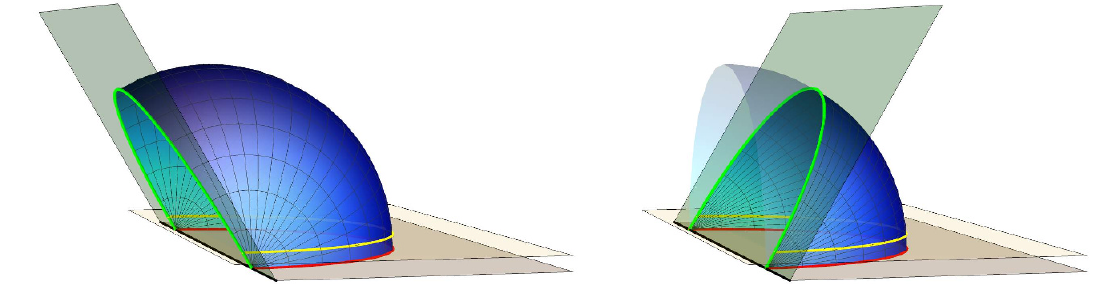
Figure 8 . Minimal surfaces ^ (cid:13) A corresponding to the half disk centered on the boundary. The green half plane is Q in (4.3), while the grey half plane is z = 0. In the left panel (cid:11) < (cid:25)= 2, while in the right panel (cid:11) > (cid:25)= 2. The green curve is ^ (cid:13) A \ Q and the red curve is the entangling curve @A \ @B , whose length enters in the area law term of (5.1). The yellow half plane is de(cid:12)ned by z = " and the yellow curve corresponds to its intersection with ^ (cid:13) A